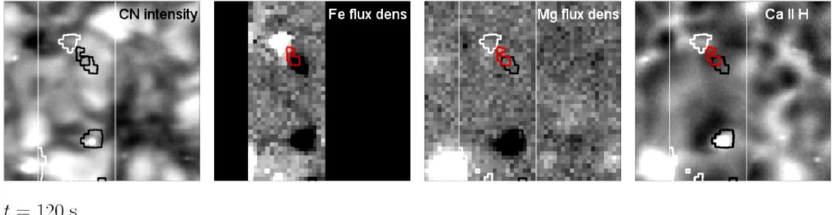
Fig.17 Still from a movie showing the ascent of a small magnetic loop through the solar atmosphere. The observations were acquired with all three instruments of the Hinode Solar Optical Telescope (the SP, the NFI, and the BFI). From left to right: CN intensity filtergrams, longitudinal flux density in the photosphere calculated from Fe i 630.1 and 630.2 nm, longitudinal flux density in the temperature minimum region computed from Mg i b 517.3 nm measurements, and Ca ii H 396.85 nm intensity filtergrams. The contours mark circular (black, white) and linear (red) polarization patches. Image reproduced with permission from Martínez González and Bellot Rubio (2009), copyright by AAS. (For movie see Electronic Supplementary